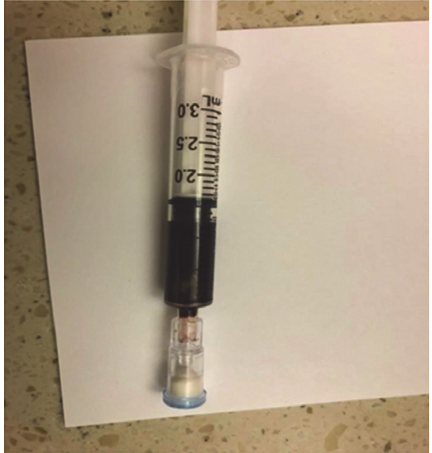
Figure 2: Patient’s initial blood